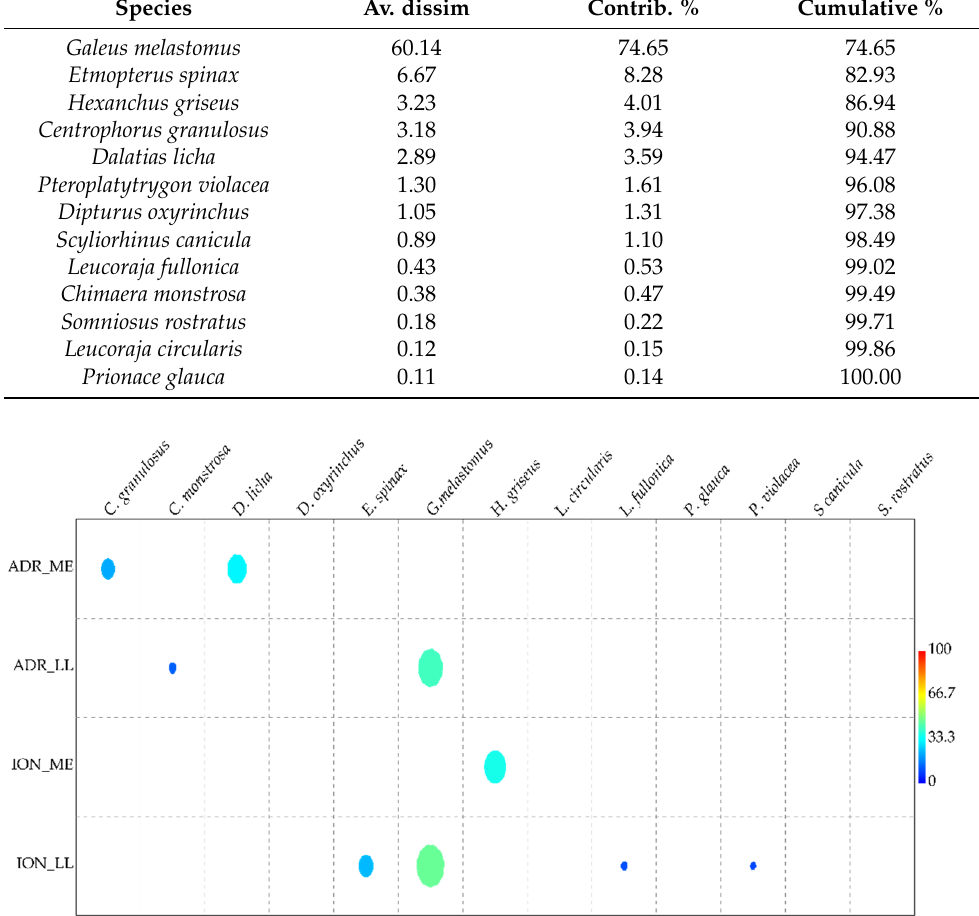
Figure 4. Indicator species analysis (IndVal) plot with representative species of Adriatic (ADR) and Ionian (ION) area and MEMO lander (ME) and longline (LL).